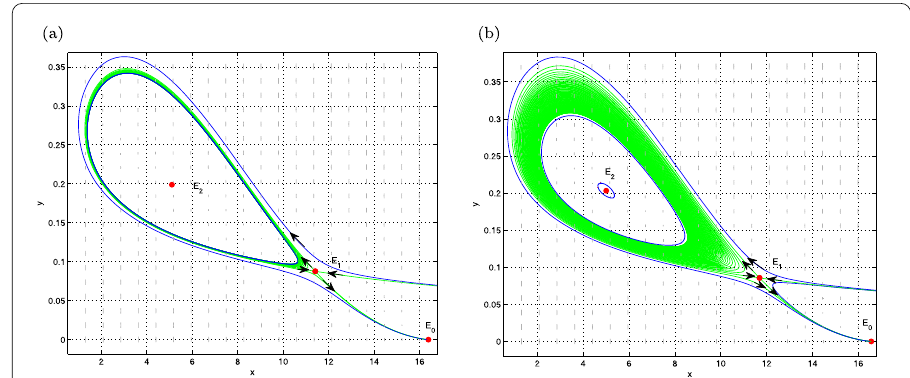
Figure 6 The phase portrait of p = 2, q = 3, A = 15.0804, α = 1. ( a ) d = 0.92, γ = 51.2025 an unstable limit cycle; ( b ) d = 0.910386, γ = 50.8022 2 limit